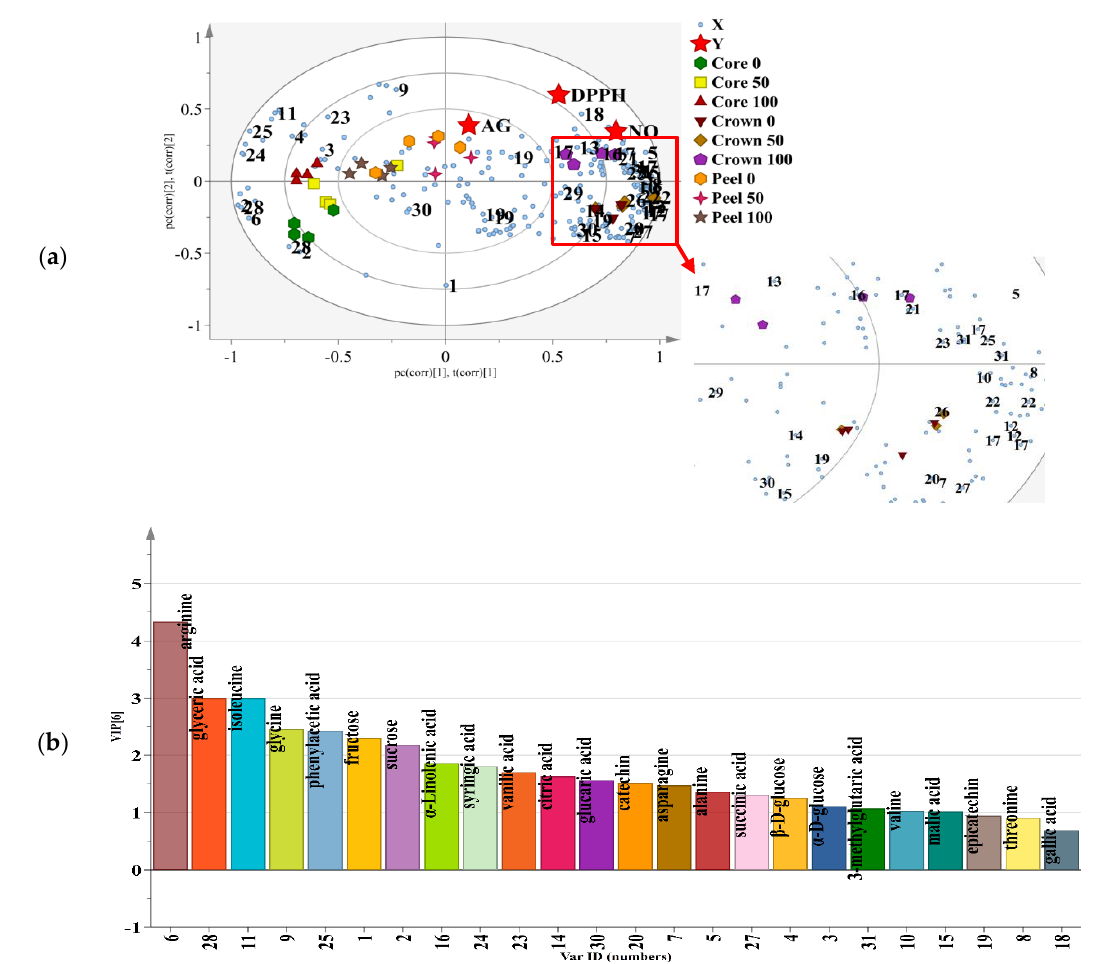
Figure 4. ( a ) The PLS biplot describing the correlation of MD2 pineapple peel, crown and core extracted with 0, 50 and 100% ethanol ratio and biological activities. See Table 1 for the assignments of metabolites. ( b ) Metabolites with variable importance in the projection (VIP) value ≥ 0.7 identified from MD2 pineapple peel, crown and core extracted with 0, 50 and 100% ethanol ratio.